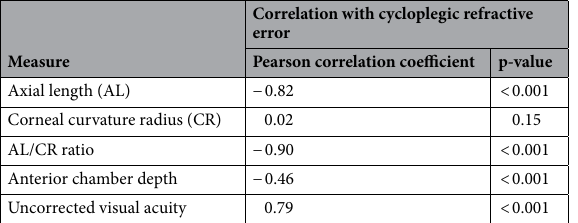
Table 2. Correlation of cycloplegic spherical equivalent with ocular biometric measures and uncorrected visual acuity.